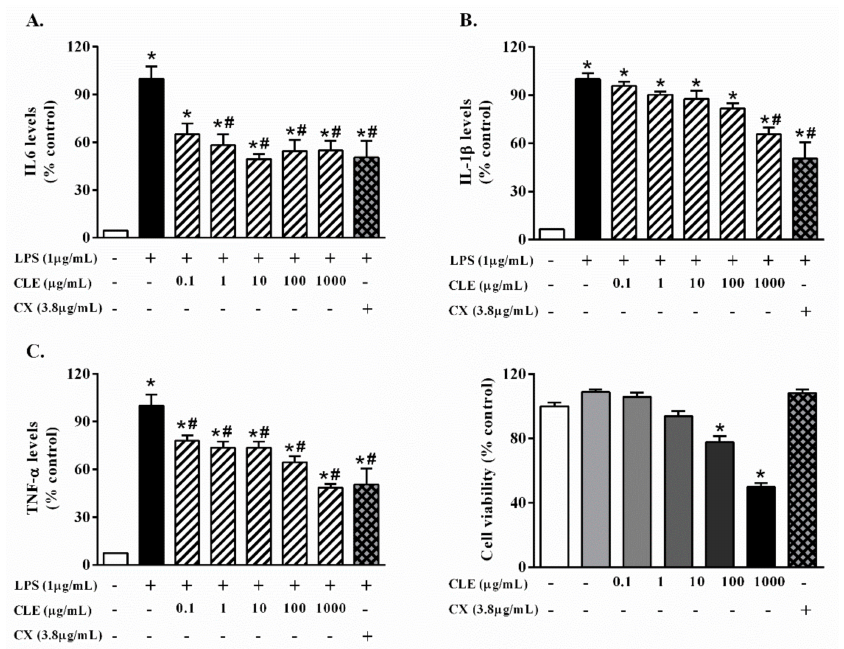
Figure 2. The effects of CLE on inflammatory cytokine production in LPS-stimulated RAW 264.7 cells. RAW 264.7 cells were treated with LPS in the absence or presence of different concentrations of CLE for 24 h. The production of ( A ) IL-6, ( B ) IL-1 β , and ( C ) TNF- α was measured by ELISA. ( D ) Viability of RAW 264.7 cells after exposure to different concentrations of CLE with or without LPS for 24 h. Values shown are mean ± S.E.M. ( n = 5); * p < 0.05 vs. control and # p < 0.05 vs.